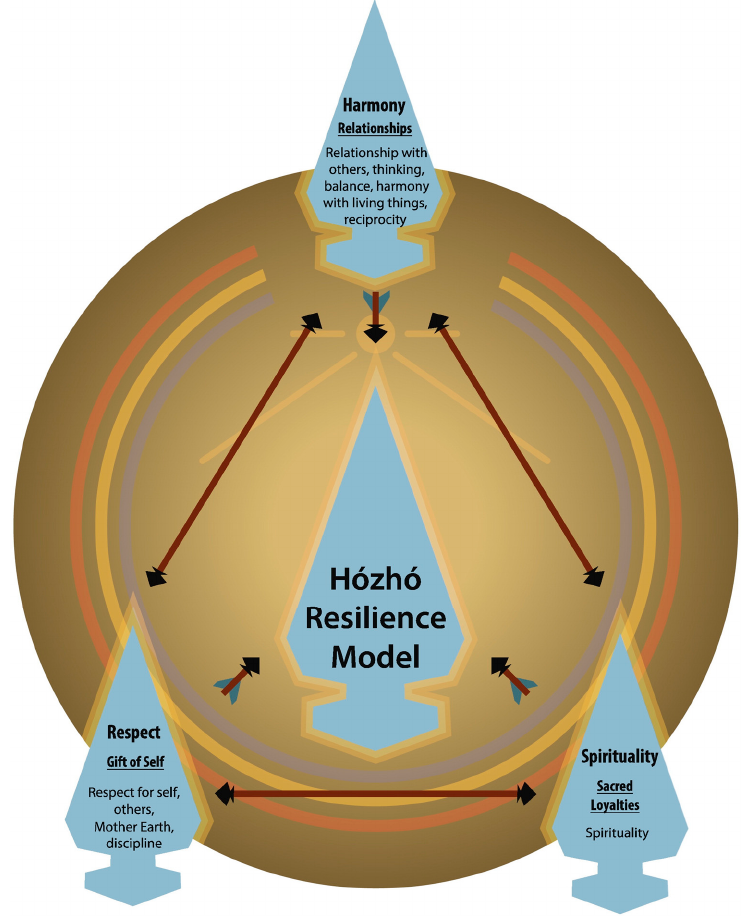
Figure 4. The Hózhó Resilience Model [41]. Figure 4. The H ó zh ó Resilience Model